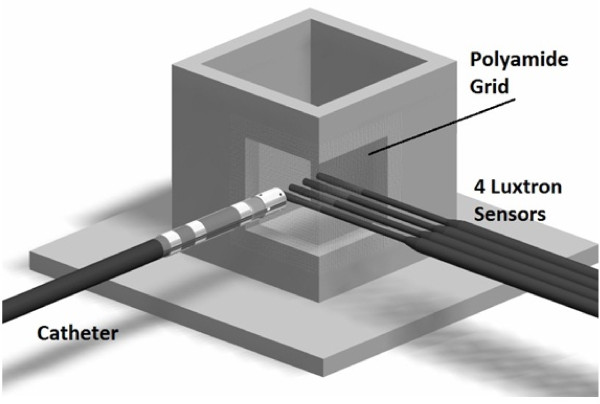
Schematic view of the test cube. The top face is left open to allow for filling with ground beef. The polyamide grid is placed firmly over the open side parts. The catheter is placed perpendicular to the polyamide grid. The polyamide grid on the neighboring side has a small slit allowing the temperature sensors to be inserted into the beef core. The sensors are placed parallel to each other and perpendicular to the catheter tip. The distances of the sensors to the catheter tip/polyamide grid surface are 0, 2, 4, and 6 mm.